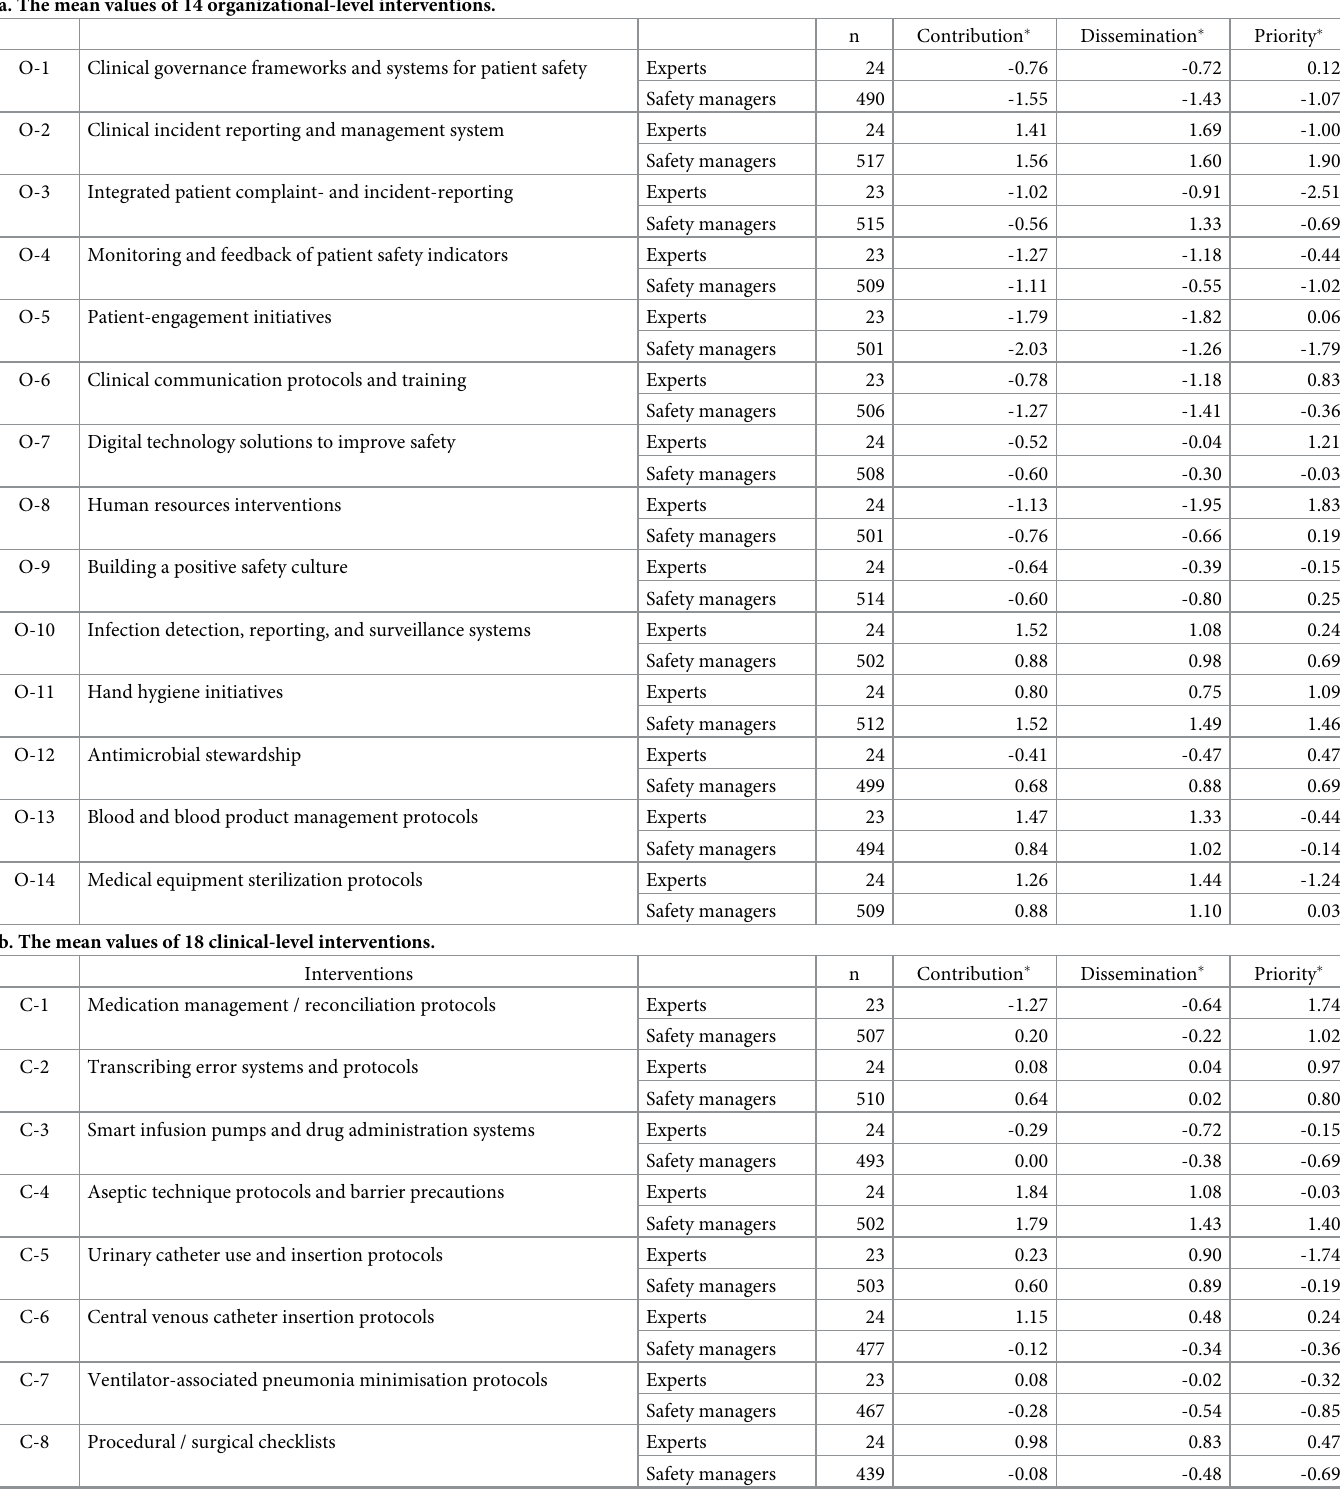
a. The mean values of 14 organizational-level